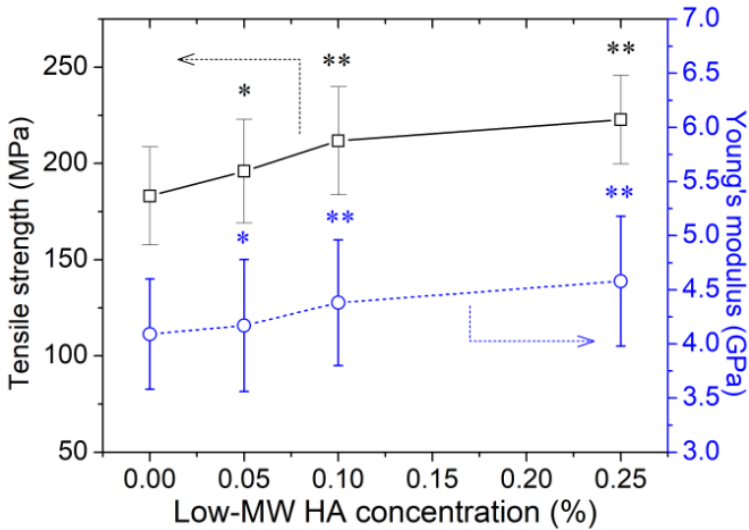
Figure 2. Effect of low-MW HA concentration on the elastic modulus and tensile strength of bleached hair. (Significance: * p < 0.05; ** p < 0.01 vs. bleached hair. N = 30).